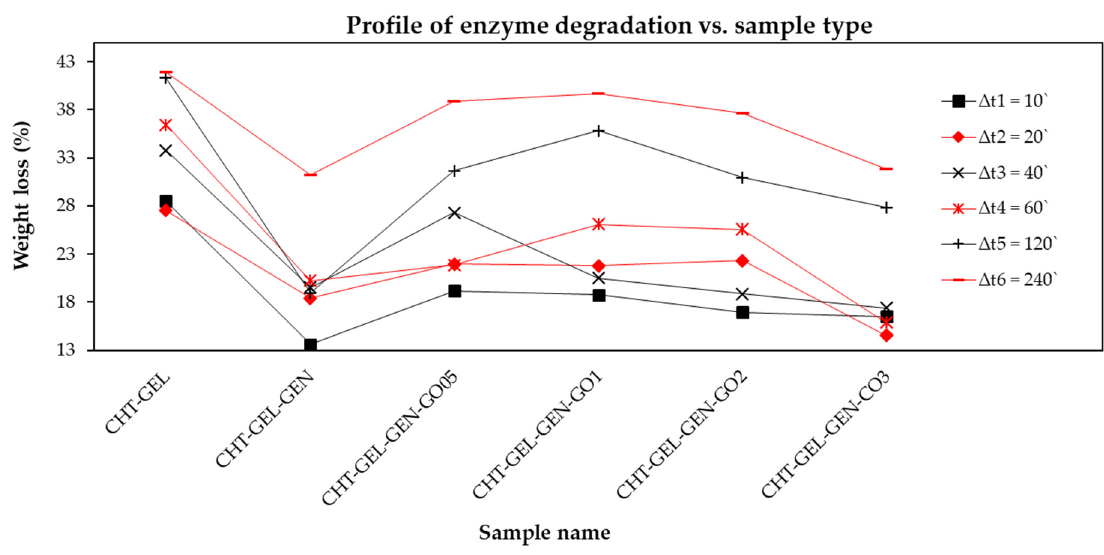
Figure 7. Time-dependent enzyme degradation weight loss of the composite films and controls.